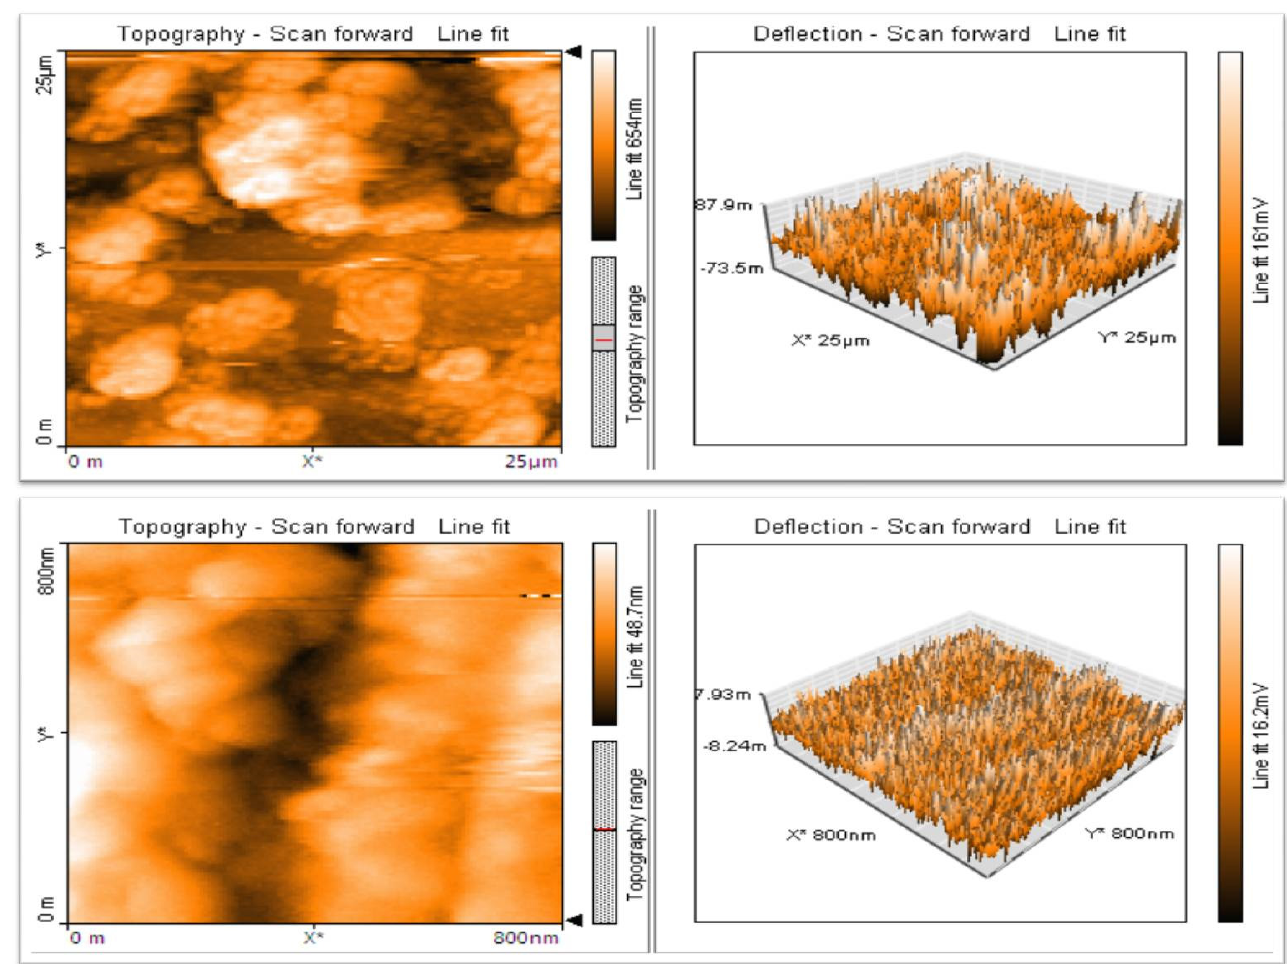
Figure 6. AFM images of M. indica seed extract synthesized ZnO NPs. (*—axis)